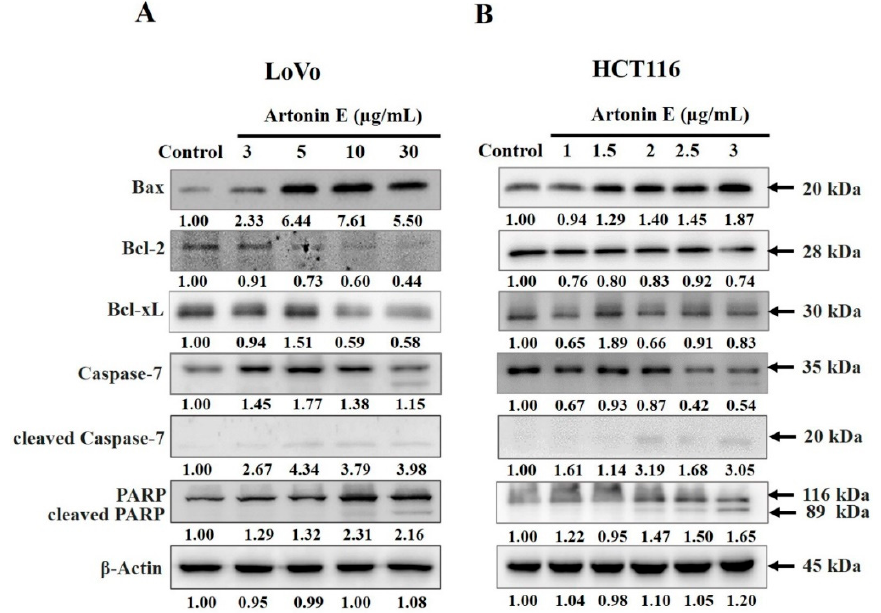
Figure 5. Effect of artonin E on apoptosis protein expression. Cells were treated with different concentrations of artonin E for 24 h. Expression of the Bcl-2 family, caspase-7, and cleaved-PARP in ( A ) LoVo cells and ( B ) HCT116 cells ( p < 0.05).